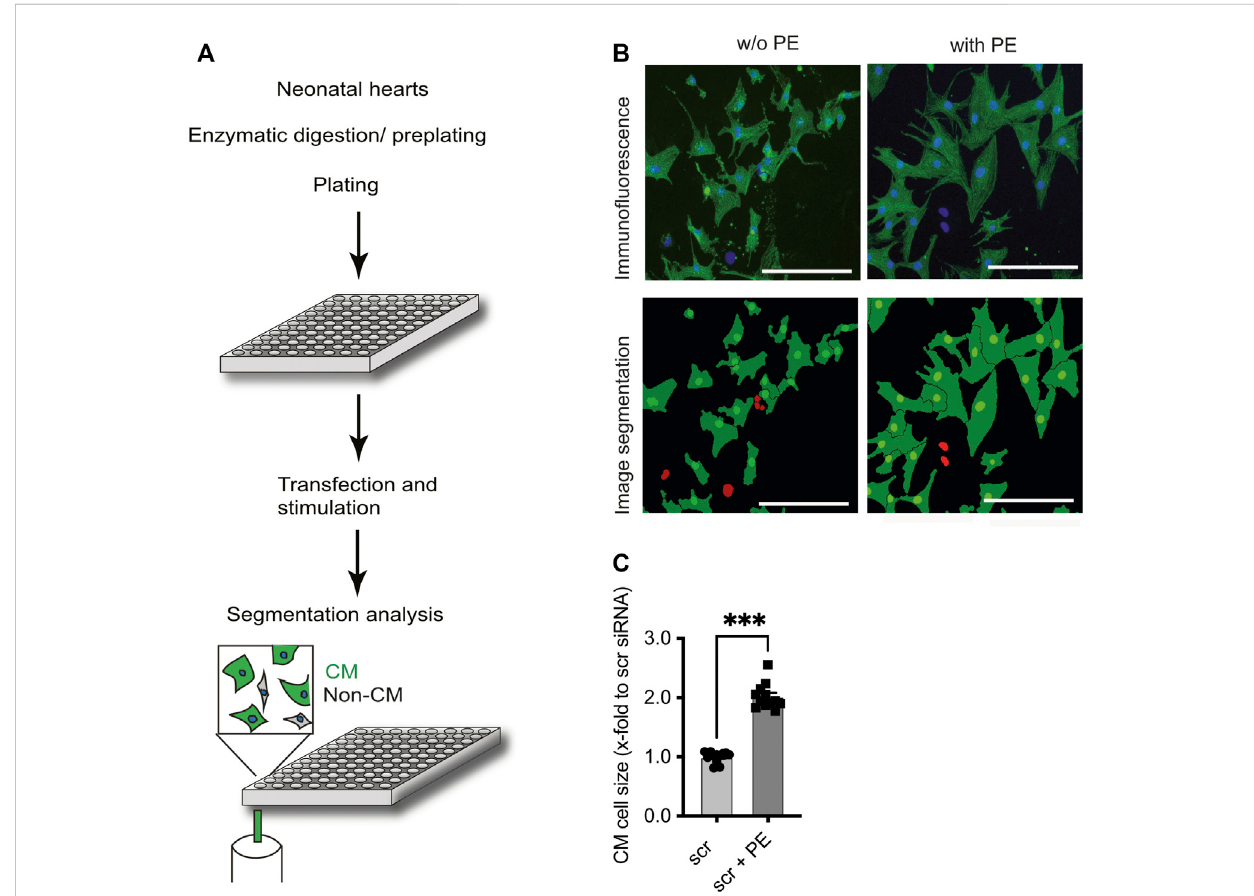
FIGURE 1 Identi fi cation of F-box protein Fbxo25 as a novel regulator of cardiomyocyte hypertrophy. (A) Schematic work fl ow: Cells were isolated from neonatal rat hearts, pre-plated to enrich for cardiomyocytes, and seeded onto 96 well plates. After transfection with 43 different siRNAs, cell identity was determined by immunostaining against α -actinin and DAPI. Cell size was quantitated by automated microscopy and image segmentation. (B) Representative immunostaining and image segmentation of neonatal cardiomyocytes in cell culture; cardiomyocytes ( α -actinin) were stained for the marker protein. Nuclei stained with DAPI in blue in immuno fl uorescence picture. Non-CM are labelled red in image segmentations. Scale bar represents 250 μ m. (C) Histograms of the effect after siRNA scramble transfection on cardiomyocyte size under basal conditions or stimulation with phenylephrine (PE) 50 µM. Dots depict cumulative data from three independent cell preparations. Each independent experiment with > 50,000 cells per group. Data are normalized to scrambled siRNA control. Independent experiments: N = 3, n = 12, unpaired Students t-test, *** p <